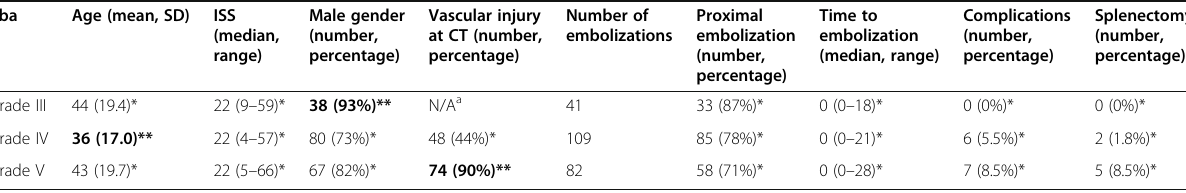
Table 4 Comparison of AAST subgroup demographics (2018 revision) and outcomes hba Age (mean, SD) ISS